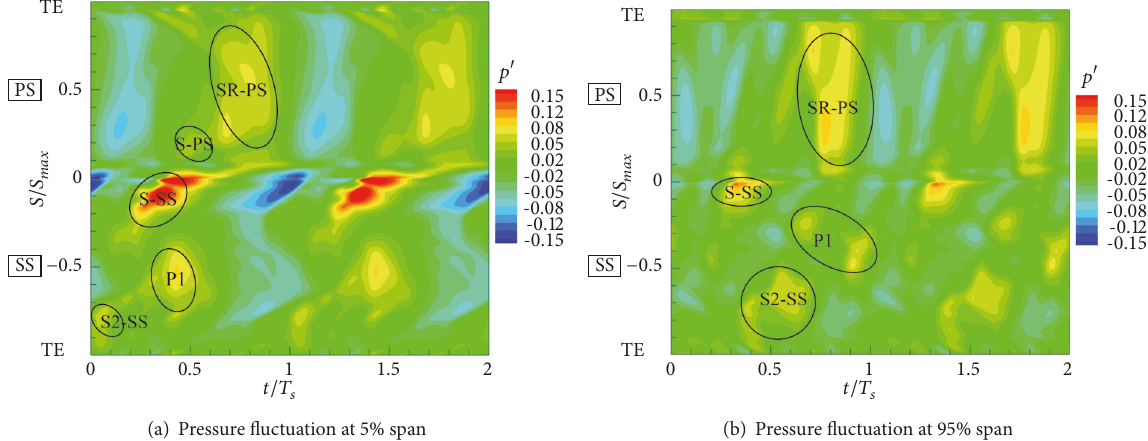
(b) Pressure fluctuation at 95 % span Figure 12: Space-time plots of the unsteady pressure at endwall regions at design vane condition with nominal expansion